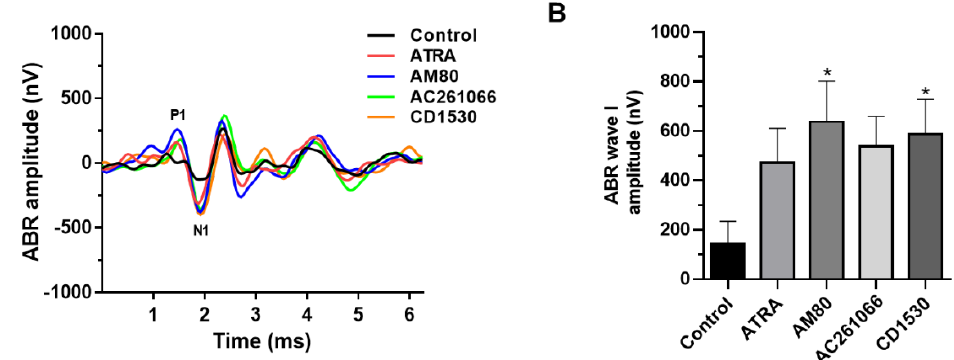
Figure 3. Comparison of wave I amplitude in auditory brainstem response (ABR). In click-evoked ABR (80 dB HL stimulus), wave I amplitude from P1 to N1 was acquired ( A ). The amplitude of wave I was significantly higher in the groups treated with ATRA and RAR agonists than the control group one day after noise exposure ( B ). Statistical analysis was performed with the reference value of lane 1. * p < 0.05.